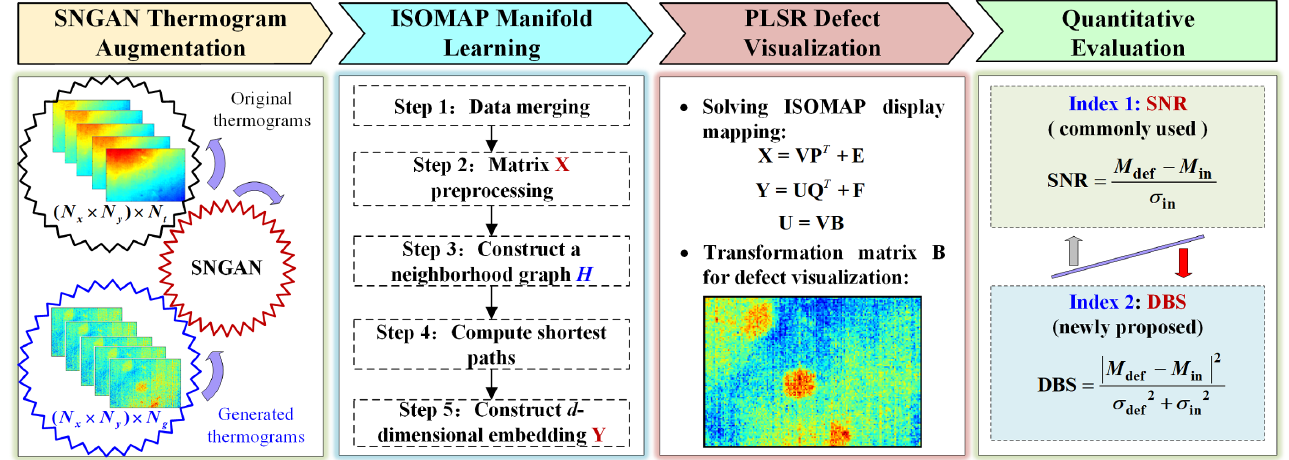
Figure 3. The GMLT framework and analysis procedure for thermographic data.